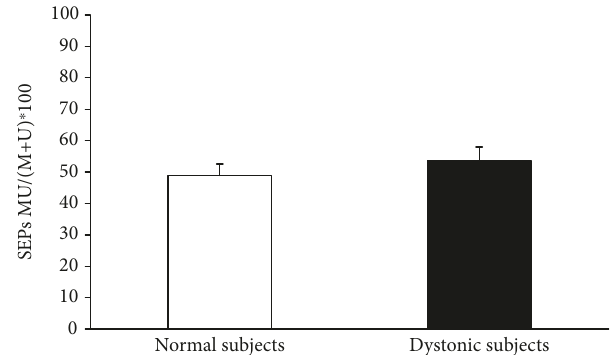
Figure 5: The MU/(M +U) ∗ 100 ratio of the cortical N20 SEP was not signi fi cantly di ff erent between dystonic patients and controls (unpaired Mann Whitney U test: Z = − 0 2 , P = 0 8